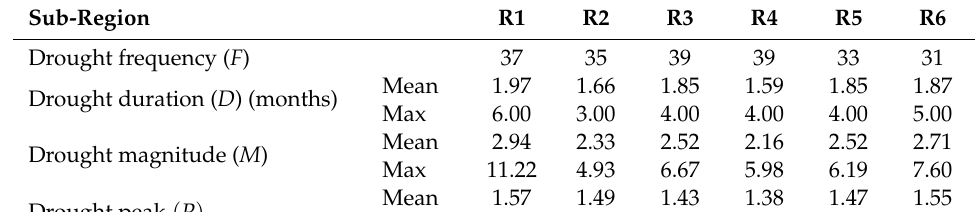
Table 2. Identified drought characteristics for the six sub-regions.